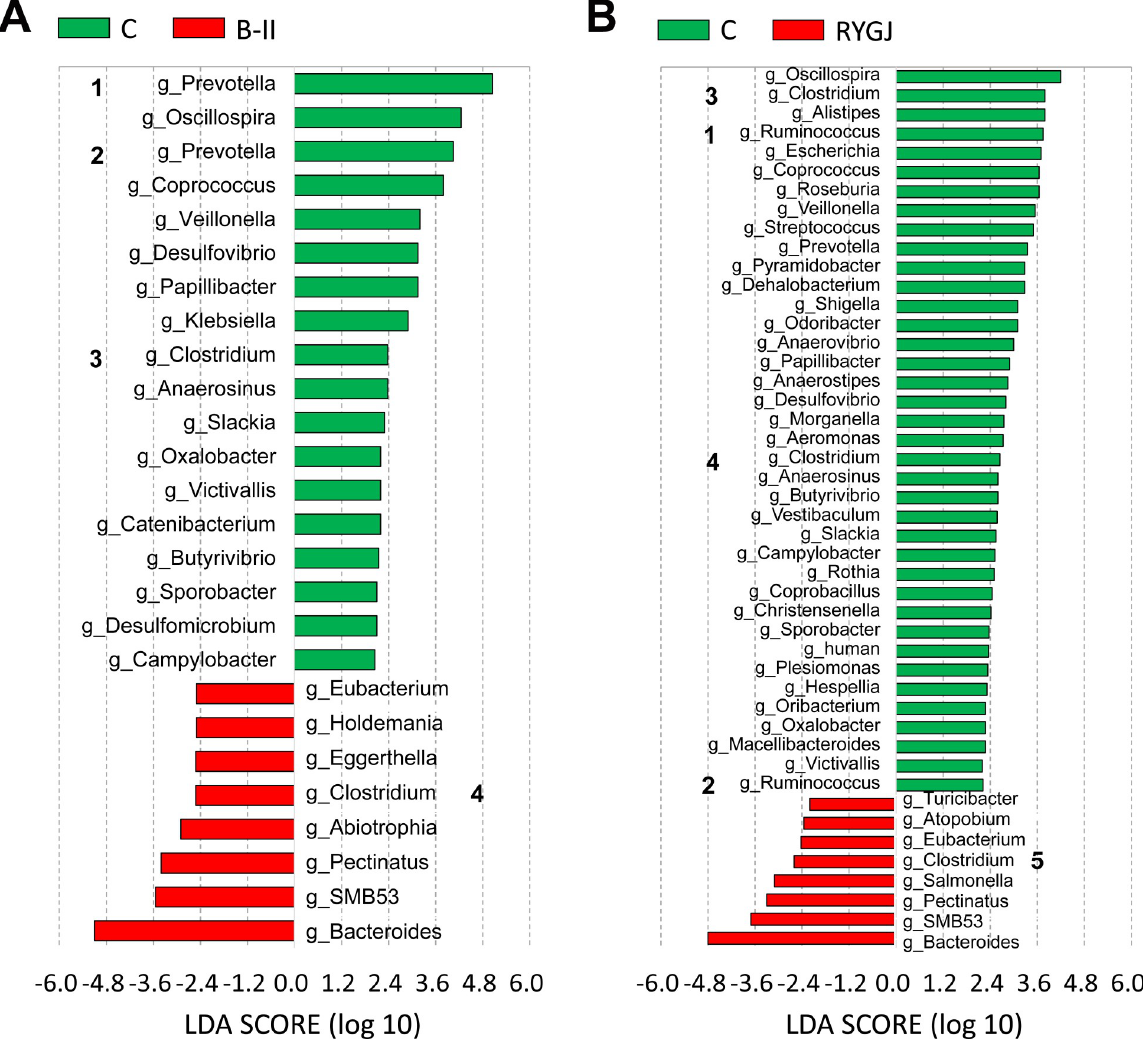
Fig 4. Known genera abundance reported by LEfSe in the bacterial community. Fig 4A. Known genera abundance reported by LEfSe in the bacterial community between B-II and control group. B-II, subtotal gastrectomy with Billroth II anastomosis. 1 This Prevotella genus is affiliated with Prevotellaceae. 2 This Prevotella genus is affiliated with Paraprevotellaceae, a recommended family (based on the Greengenes database). 3 This Clostridium genus is affiliated with Ruminococcaceae . 4 This Clostridium genus is affiliated with Peptostreptococcaceae , a recommended family (based on the Greengenes database) Fig 4B. Known genera abundance reported by LEfSe in the bacterial community between RYGJ and control group. RYGJ, Roux-en-Y gastrojejuno anastomosis. 1 This Ruminococcus genus is affiliated with Ruminococcaceae. 2 This Ruminococcus genus is affiliated with Lachnospiraceae, a recommended family (based on the Greengenes database). 3 This Clostridium genus is affiliated with Lachnospiraceae . 4 This Clostridium genus is affiliated with Ruminococcaceae. 5 This Clostridium genus is affiliated with Peptostreptococcaceae , a recommended family (based on the Greengenes